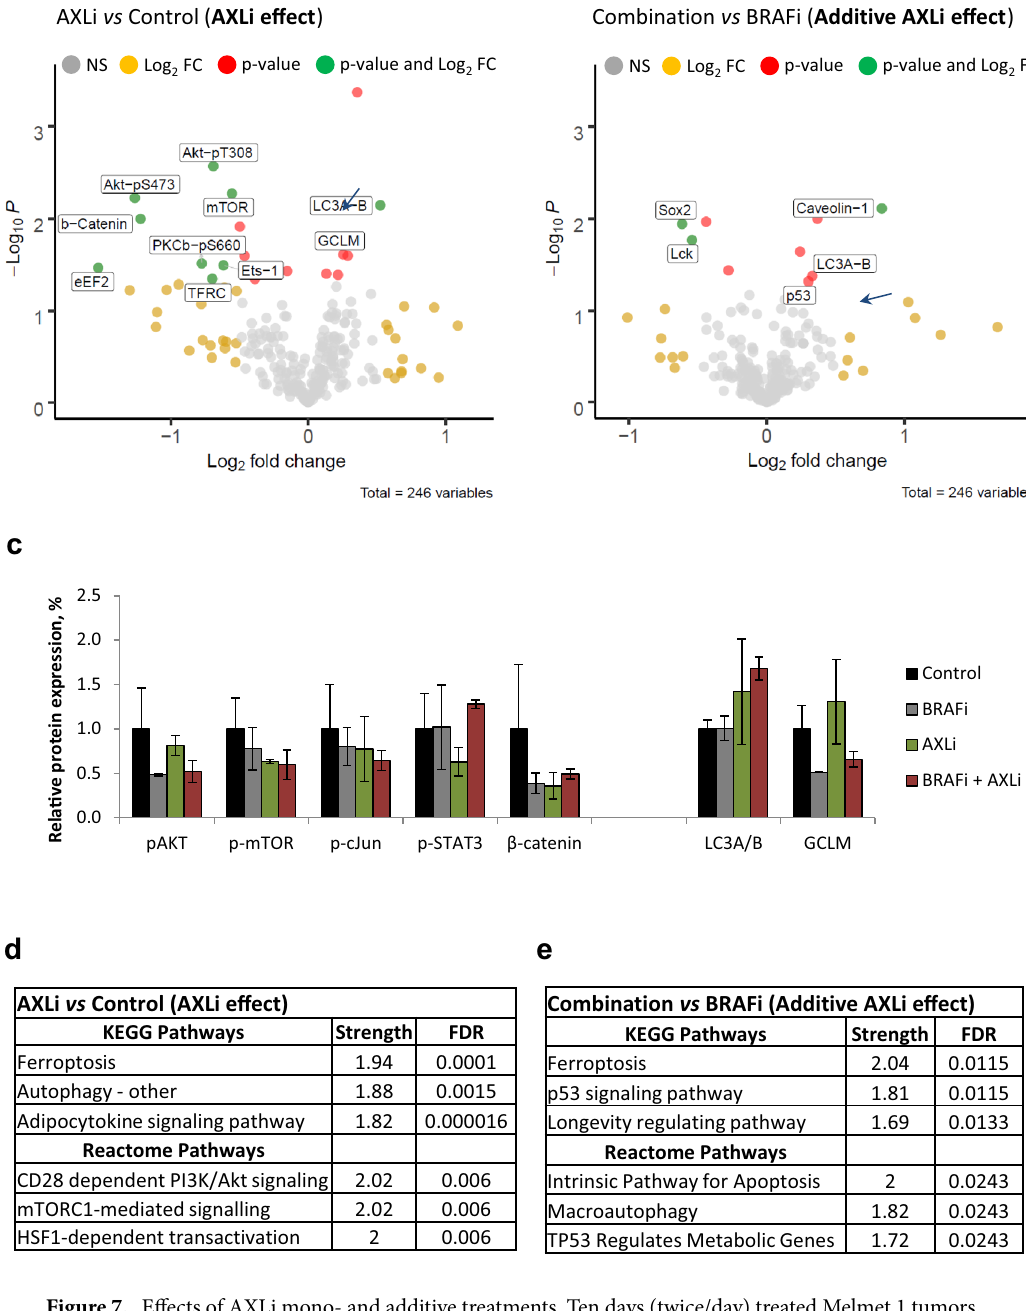
Figure 7. Effects of AXLi mono- and additive treatments. Ten days (twice/day) treated Melmet 1 tumors (BRAFi: 12.5 mg/kg, AXLi: 50 mg/kg, the combination or vehicle (DMSO/methylcellulose)) were subjected to RPPA analysis and AXLi-induced effects on protein expression either upon mono-treatment “AXLi vs. control” ( a ) or as an additive effect when combined with BRAFi “Combination vs BRAFi” ( b ) presented as volcano plots. Differentially expressed proteins: only p value < 0.05 (red), only log2 fold change difference (log 2 FC) > 0.5 (yellow) and both p value < 0.05 and log 2 FC > 0.5 (green). Not significantly (NS) changed proteins indicated in grey. Positive and negative log 2 FC values represent increased and decreased protein expression, respectively, in AXLi vs Control or AXLi + BRAFi vs BRAFi treated tumors. ( c ) Expression levels of proteins (after normalization to the loading control, α-tubulin) measured by SWI in the treated tumors as indicated. Average ± St.Dev., n = 2. ( d , e ) Top three identified functional enrichments (ranked based on strength set to be above 1.5) within KEGG 65 and Reactome signaling pathway databases, analyzed by STRING (www. string- db. org), in AXLi- mono-treated ( d ) or as a part of combination with BRAFi ( e ). Strength and False Discovery Rate (FDR) describe how large and significant, respectively, the enrichment effect